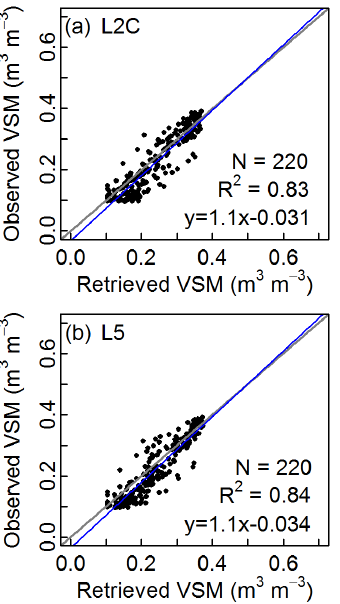
Figure 5. Scatter plots of daily mean in situ VSM observations at a depth of 5cm vs. GNSS VSM retrievals ( N = 220): from (a) L2C SNR data, and (b) L5 SNR data. The SNR data acquired by the 29.4m antenna with a 10s sampling interval during TS1 were used.